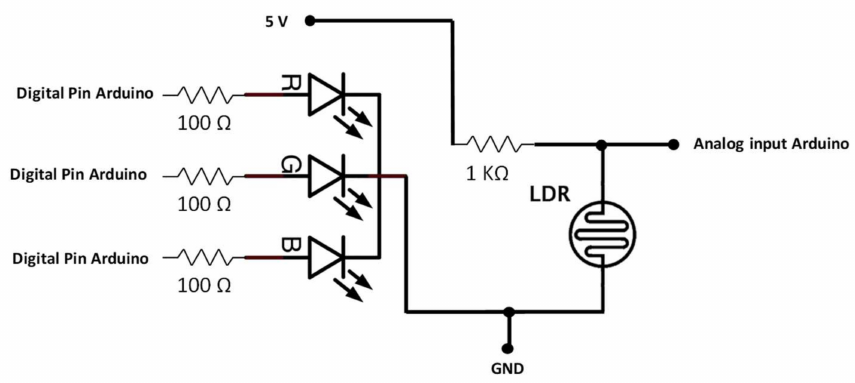
Figure 3. Schematic of RGB